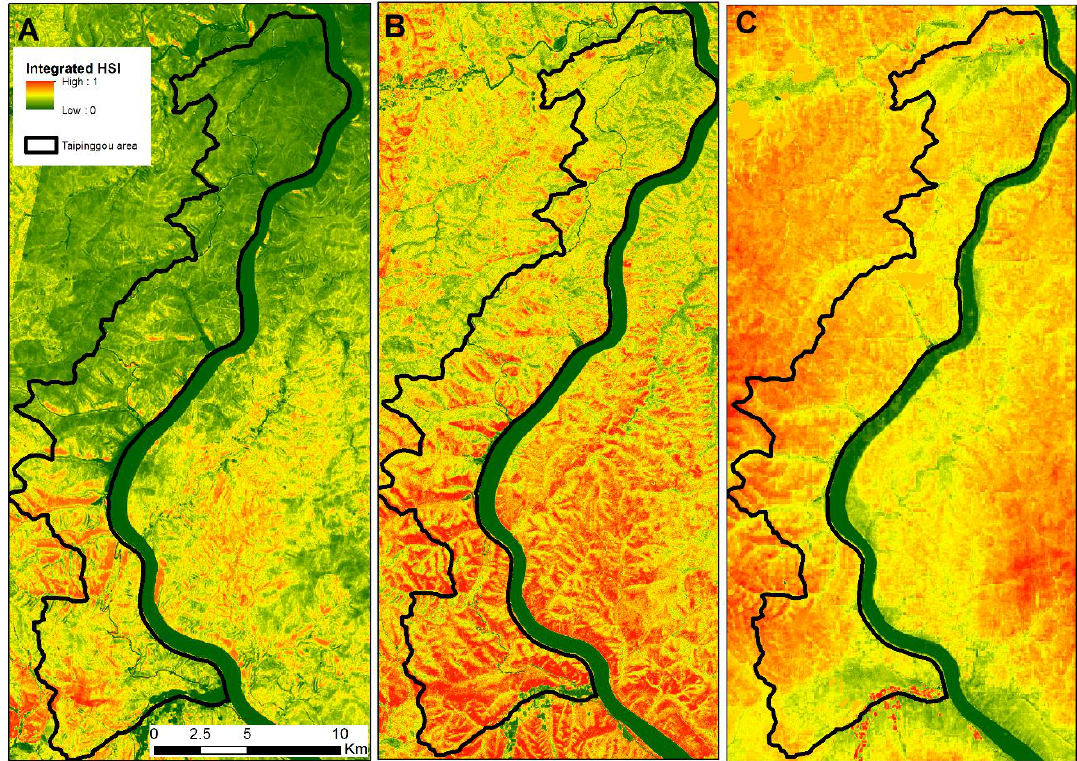
Figure A1. Three integrated prey-based habitat suitability models: ( A ) MaxEnt modeling based on the Lesser Khingan winter track census survey, ( B ) discriminant analysis based on the Lesser Khingan winter track census survey, ( C ) discriminant analysis based on Taippingou winter track census survey.